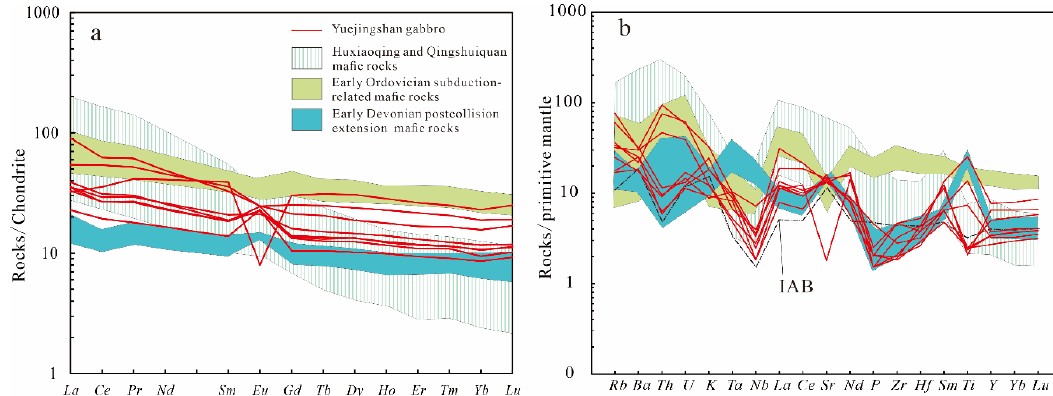
Figure 5. Chondrite-normalized rare-earth element distribution patterns ( a ) normalization values modified from Taylor and McLennan [54]) and primitive mantle-normalized trace element spider diagrams; ( b ) normalization values modified from Sun and McDonough [55] of Yuejinshan gabbro samples. Island arc basalt (IAB) data are from Niu and O’Hara [56]; data of early Ordovician subduction-related mafic rocks are from Cui, Meng [38]; data of Huxiaoqing mafic rocks are from Liu, Ma [10]; data of Early Devonian postcollision extension mafic rocks are from Liu, Ma [57].